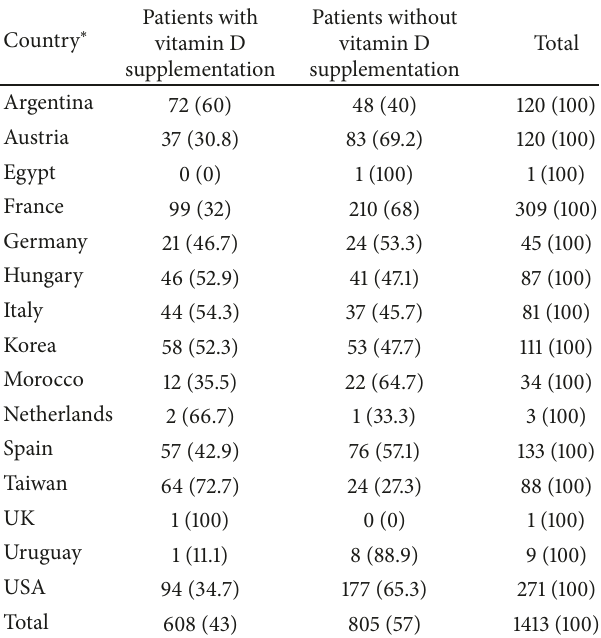
Table 6: Vitamin D intake according to countries.